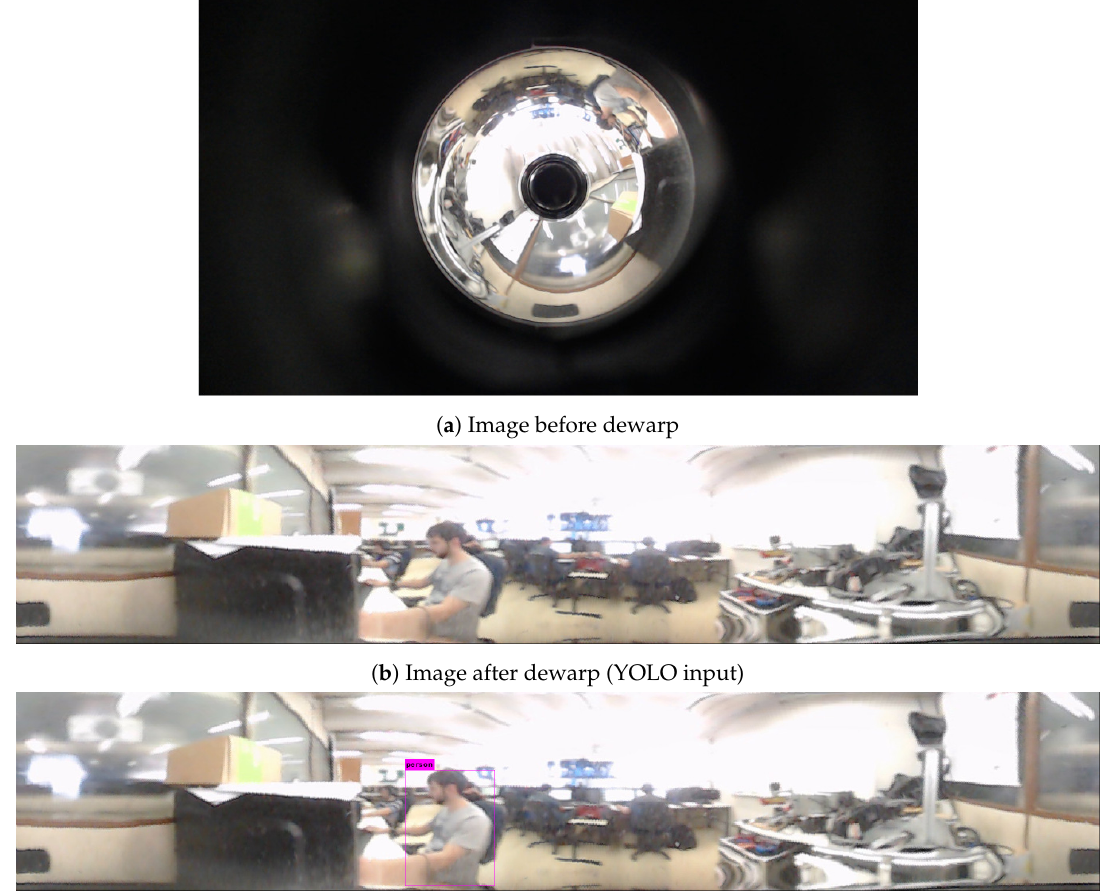
Figure 3. Conversion of the camera acquisition to panoramic image, which is fed to the YOLO object